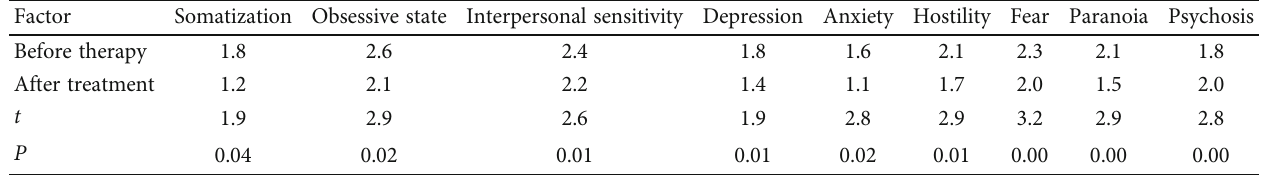
Table 3: Comparison of SCL-90 assessment results before and after music education and psychological counseling stability.